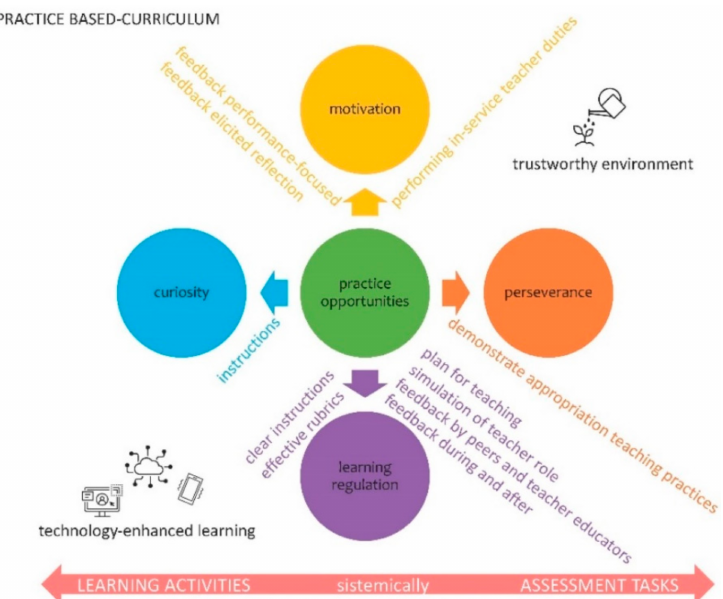
Figure 4. A practice-based curriculum offers opportunities to promote lifelong learning tendencies. Future teachers will exercise their profession in the context of Education 4.0; thus, universities cannot avoid preparing them to teach effectively in changing and